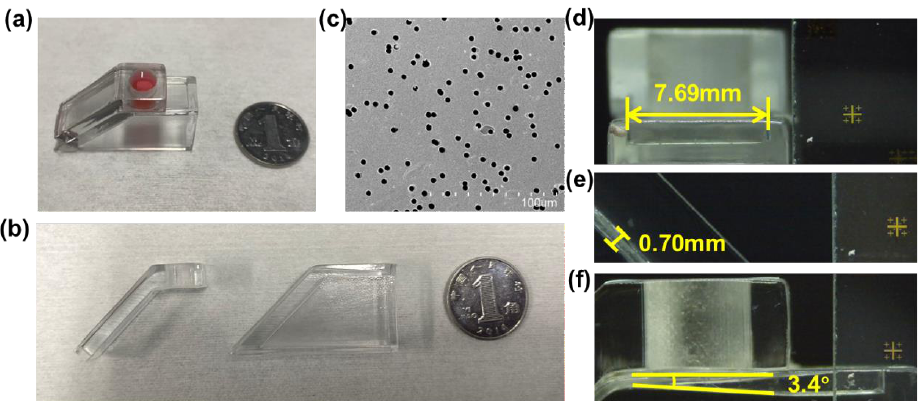
Figure 2. Fabrication of the 3D trigger valve. ( a ) Photograph of the fabricated valve in the assembled state. ( b ) Photograph of the fabricated valve in the disassembled state. ( c ) SEM image of the microporous membrane (pore size = 5 μm, porosity = 11.8%, thickness = 10 μm). ( d ) Microscopic image of the wedge-shaped capillary channel with ~8 mm in width. ( e ) Microscopic image of the slope capillary channel with 0.7 mm in height. ( f ) Microscopic image of the wedge-shaped capillary channel with 3.4 ◦ in the wedge angle.